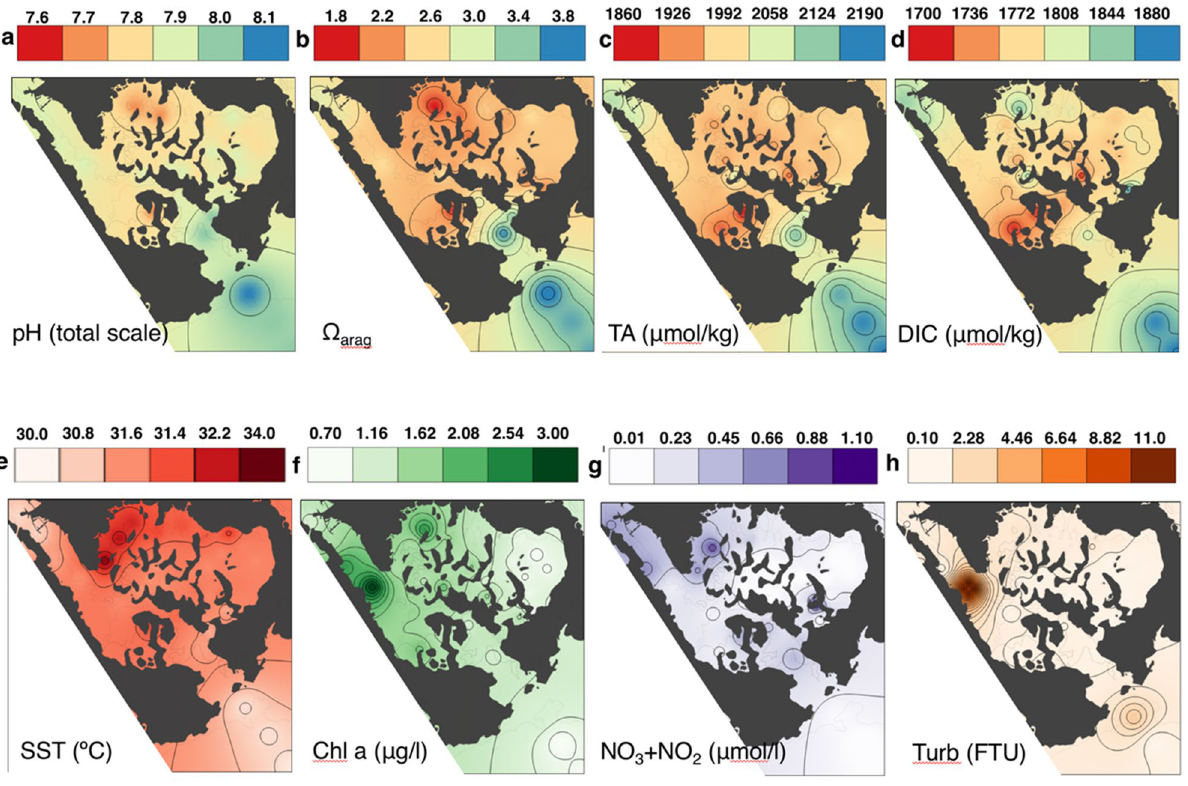
Figure 2. Spatial gradient of ( a ) pH (total scale), ( b ) aragonite saturation state (Ω arag ), ( c ) total alkalinity (TA, μmol equivalent kg −1 ), ( d) dissolved inorganic carbon (DIC, μmol kg −1 ), ( e ) sea surface temperature (SST, °C), ( f ) chlorophyll- a (Chl- a , µg L −1 ), ( g ) nitrate + nitrite (NO 2 − + NO 3 − , μmol L −1 ) and ( e ) turbidity (FTU) in sea surface water during daytime around Nikko Bay. See Tables S1 and S2 for details. The figure is created using QGIS 3.8.1 (https:// www. qgis.